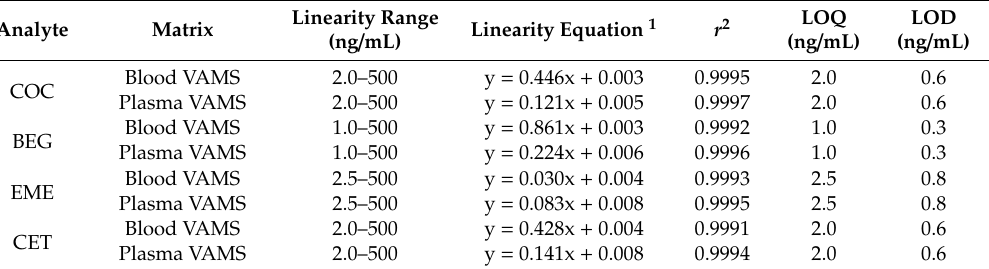
Table 2. Linearity, LOQ, LOD on spiked matrices.